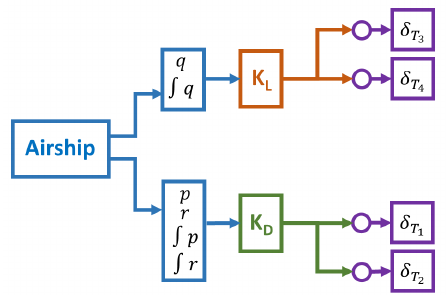
Figure 5. Stability augmentation logic for layout (B).